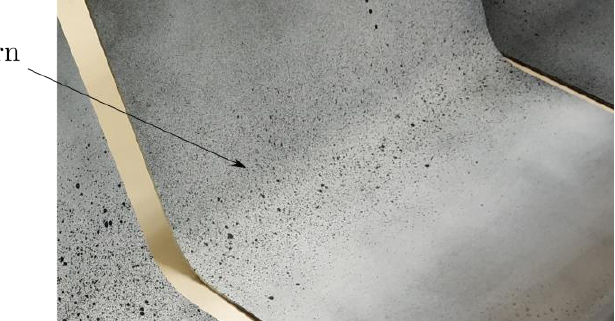
Figure 4. Photograph showing the white/black speckle pattern on the rear surface of the V-structure.